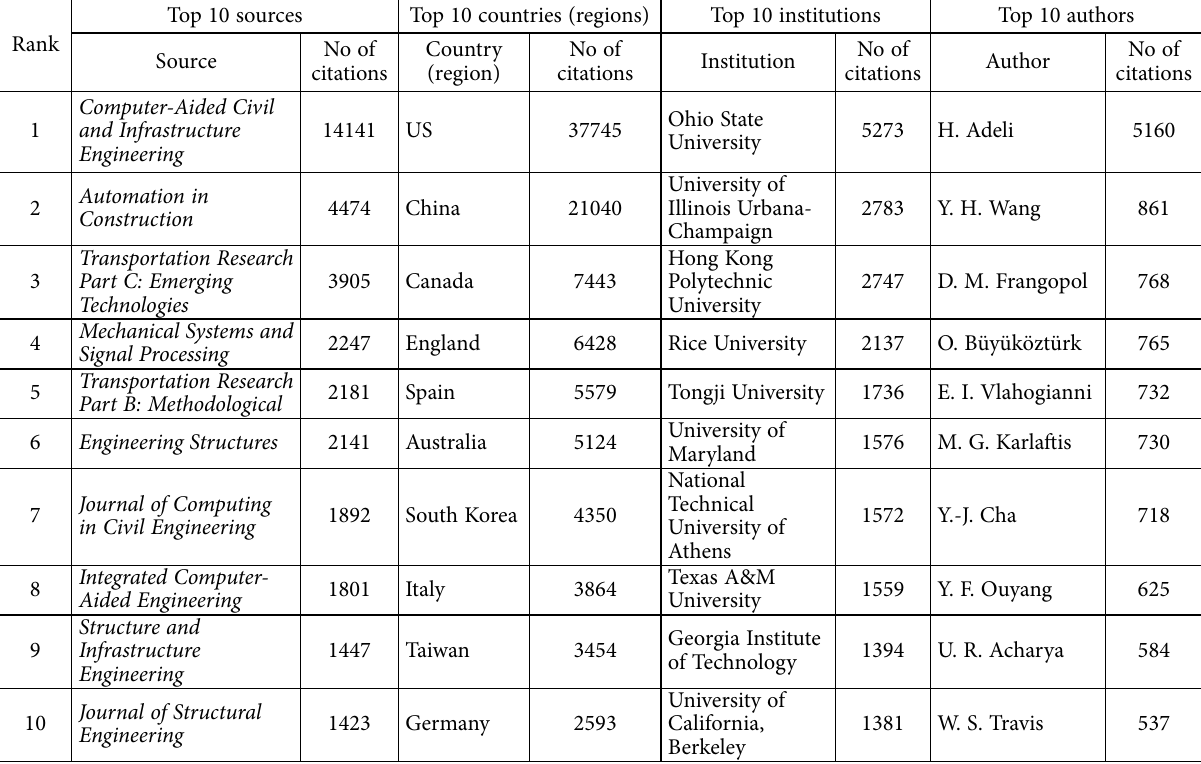
Table 1. Top 10 sources/countries (regions)/institutions/authors of cited publications in the CACAIE Top 10 sources Top 10 countries (regions) Rank No of Country Source citations